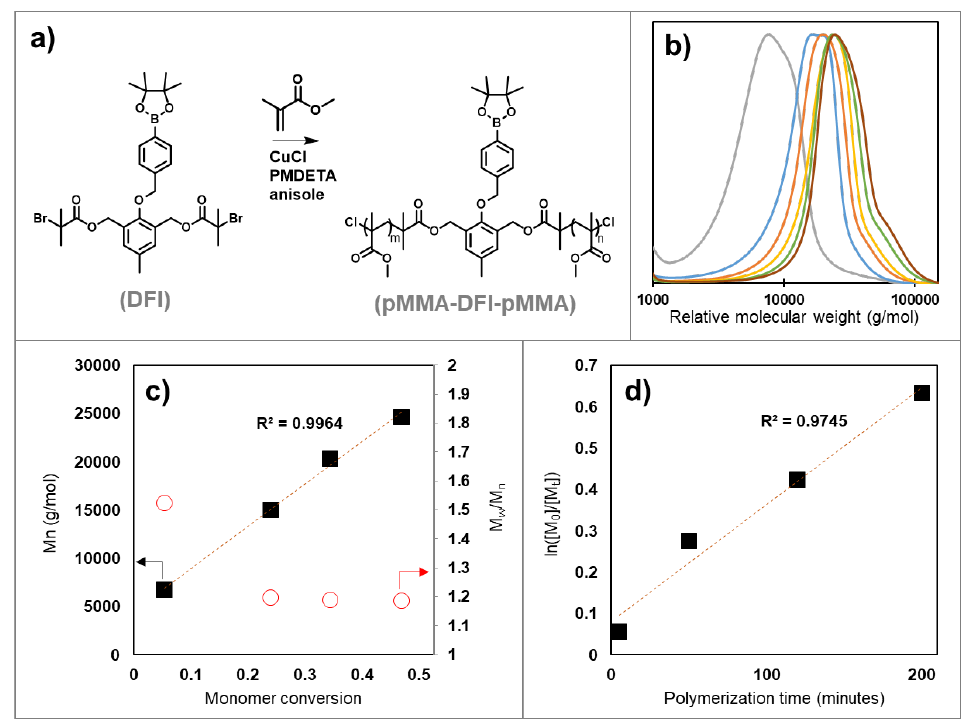
Figure 4. Monitoring the evolution of molecular weight and polydispersity in the ATRP of methyl methacrylate using the difunctional initiator (DFI): ( a ) Polymerization of methyl methacrylate using the DFI, T = 55 °C, [MMA] 0 /[DFI] 0 /[CuCl] 0 /[PMDETA] 0 = 400/1/2.24/2; ( b ) SEC traces obtained from samples taken at 15, 50, 95, 120, 160, and 200 min for a representative synthesis of pMMA-DFI- pMMA (versus pMMA standards in THF); ( c ) Evolution of molecular weight (solid black squares) and polydispersity (hollow red circles) versus monomer conversion in the ATRP of MMA during a representative polymerization; ( d ) First-order kinetic plot for the ATRP of MMA using the DFI.